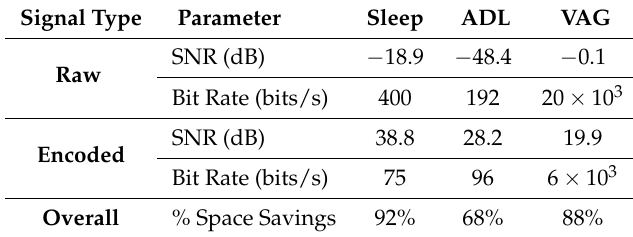
Table 4. Parametric Encoding